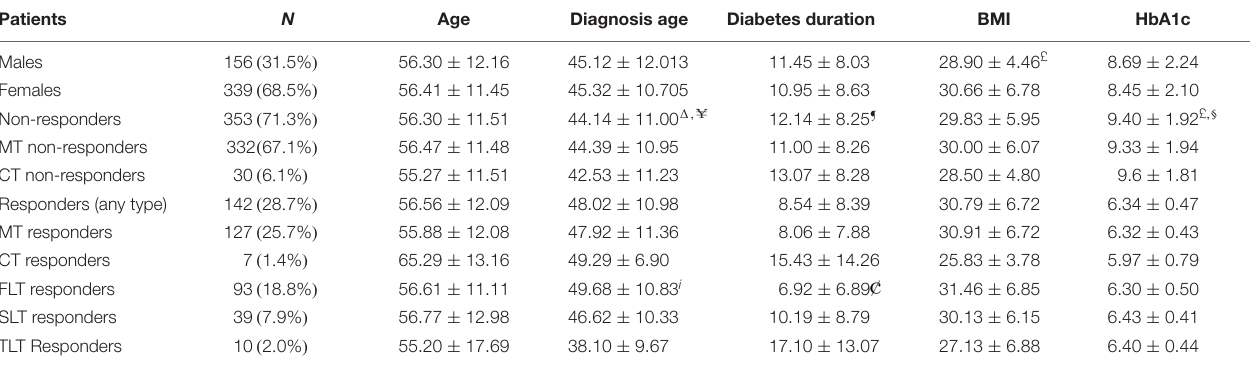
TABLE 1 | Demographic and clinical data of